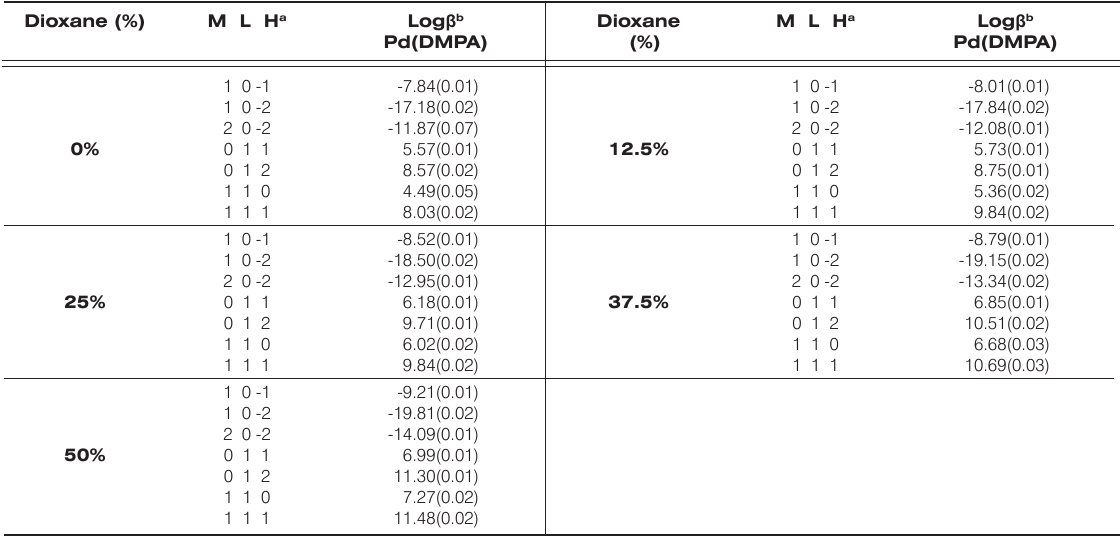
Table 2. Formation constants for the complex of [Pd(DMPA)(H and at 25° C and 0.1 M ionic strength. Dioxane (%)